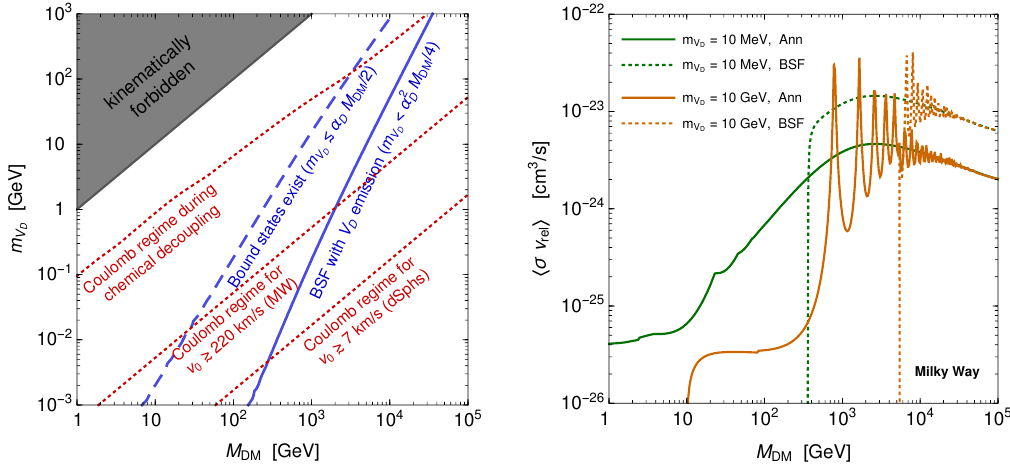
Figure 12 . (Plots reproduced from ref. [18].) We consider dark matter consisting of Dirac Fermions X; (cid:22) X , of mass M DM , that couple to a dark photon of mass m V . We assume that the DM relic D density arose from thermal freeze-out in the hidden sector, and determine the dark (cid:12)ne-structure constant (cid:11) D as a function of M DM and m V , taking into account both the direct DM annihilation D into radiation and the formation and decay of unstable bound states, wherever applicable, according to ref. [7]. Left: below the blue dashed line, the Bohr momentum of the X (cid:0) (cid:22) X pair is larger than the dark photon mass ( (cid:24) & 1); bound states exist (cf. appendix A.2) and the Sommerfeld e(cid:11)ect is signi(cid:12)cant. However, bound states can form with emission of a dark photon only in the parameter space below the blue solid line, where the mediator mass is less than the binding energy. Below the red dotted lines, the average momentum transfer between X and (cid:22) X is larger than the mediator mass, ( M DM = 2) v rel & m V [or (cid:24) & (cid:16) , cf. eq. (2.4)], for typical velocities during the DM chemical D decoupling in the early universe, in the Milky Way, and in the Dwarf Spheroidal galaxies, as p indicated in the plot. (We take v rel = 2 v 0 .) In this regime, the interaction cross-sections are well approximated by their Coulomb limit. In the Coulomb limit, bound-state formation is faster than annihilation, (cid:27) f 100 g ’ 3 : 13 (cid:27) ann [cf. (cid:12)gure 2 and eqs. (3.8d), (3.14d)]. Right: the cross-sections BSF times relative velocity, for annihilation (solid lines) and radiative capture to the ground state (dotted lines), averaged over the DM velocity distribution in the Milky Way ( v 0 = 220 km/s, v esc = 533 km/s), for two di(cid:11)erent values of the dark photon mass, m V = 10 MeV (green smooth D lines) and m V = 10 GeV (orange lines with resonances). For m V = 10 MeV, the Coulomb limit D D pertains to M DM & 10 GeV, as can be seen in the left panel. Bound-state formation is faster than annihilation wherever it is kinematically allowed, M DM & 400 GeV. For M DM . 1 TeV, the Sommer- feld e(cid:11)ect is not signi(cid:12)cant during freeze-out, which implies roughly (cid:11) D / M DM . However, in